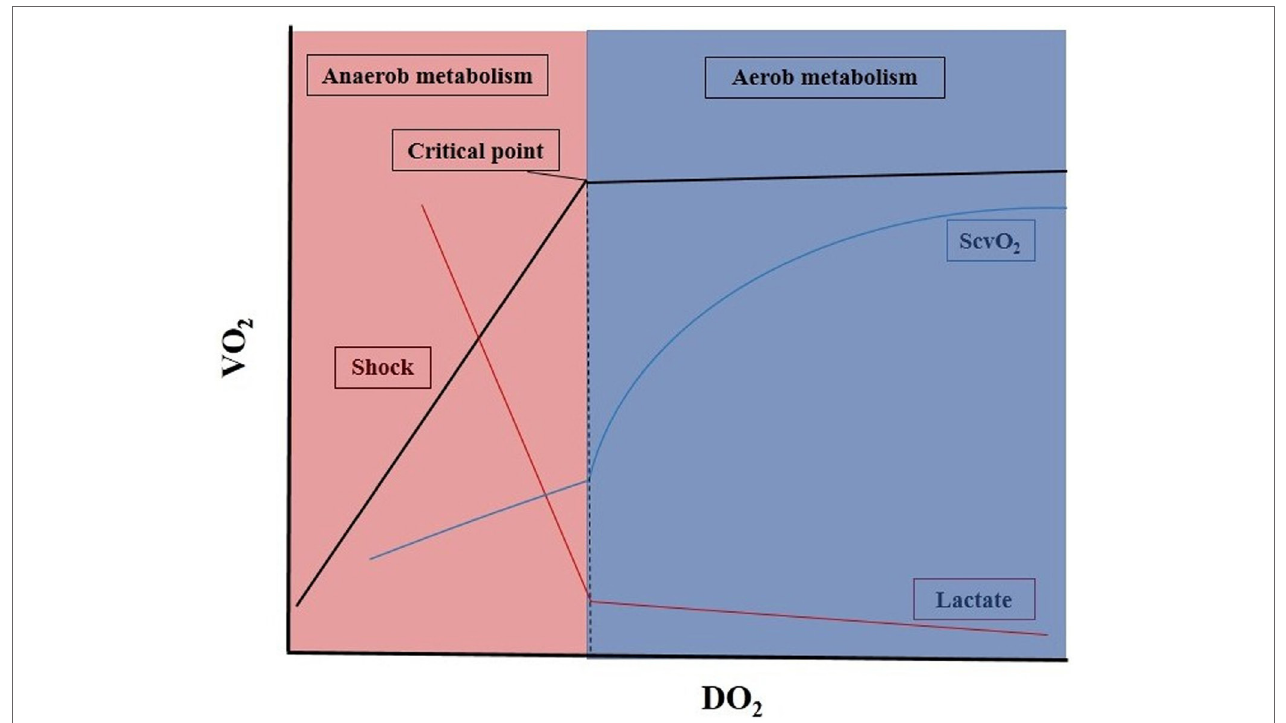
FiGURe 1 | Oxygen delivery and consumption in critically ill patients. DO 2 , oxygen delivery; VO 2 , oxygen consumption; ScvO 2 , central venous oxygen saturation ratio. For details, see main